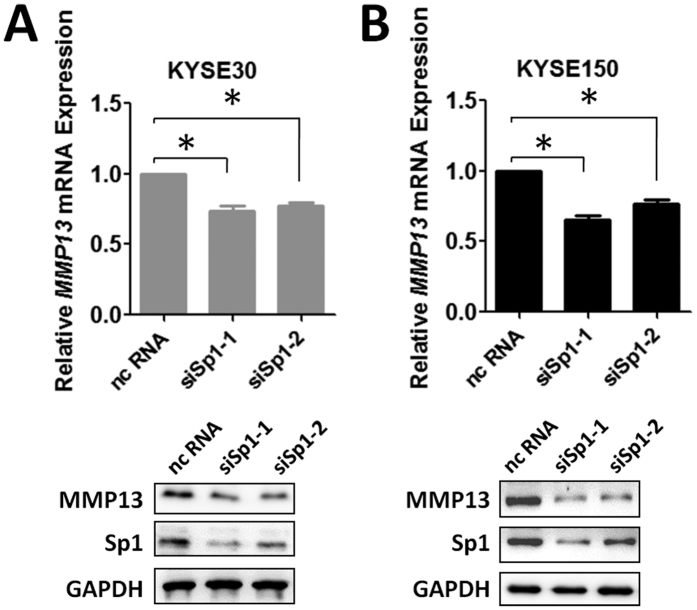
Silencing Sp1 expression repressed MMP13 expression in KYSE30 and KYSE150 cells.The expression of individual MMP13 mRNA was calculated relative to expression of β-actin. *P < 0.05. Protein expression of MMP13, Sp1 and GAPDH was detected using Western Blotting.